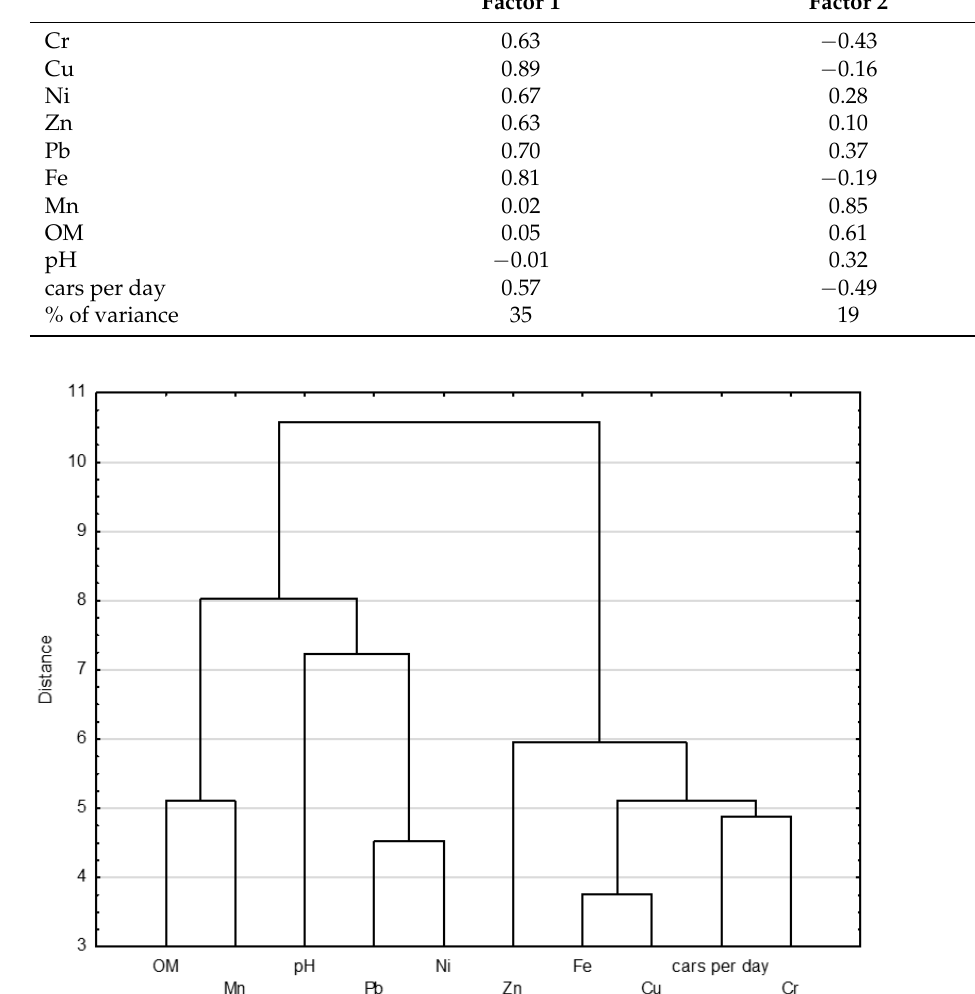
Figure 6. Hierarchical dendrograms for heavy metals in dust obtained by Ward’s hierarchical clustering method.